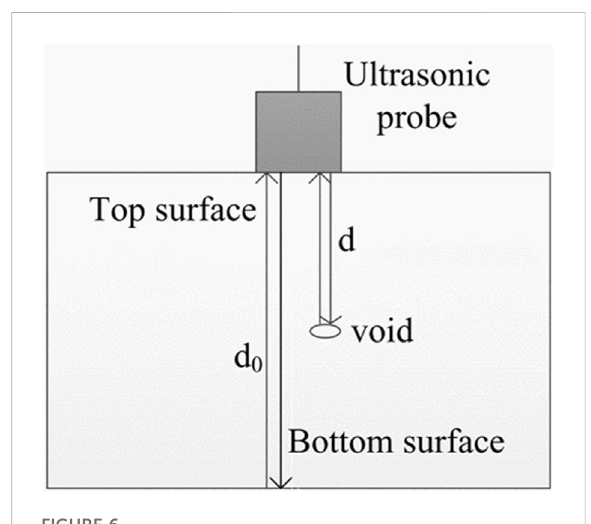
FIGURE 6 The principle of ultrasonic detection (Zhao et